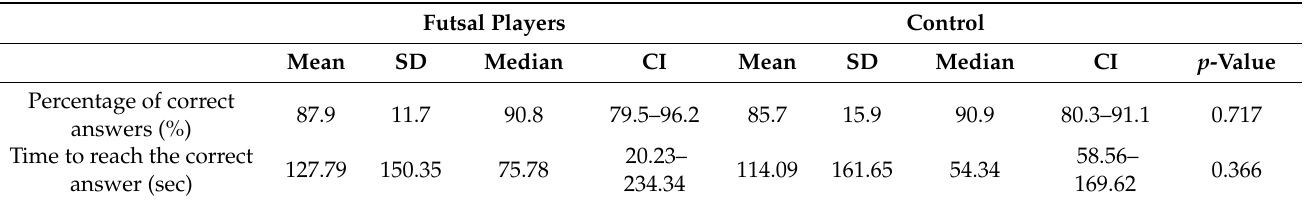
Table 6. Results of the visual memory test .